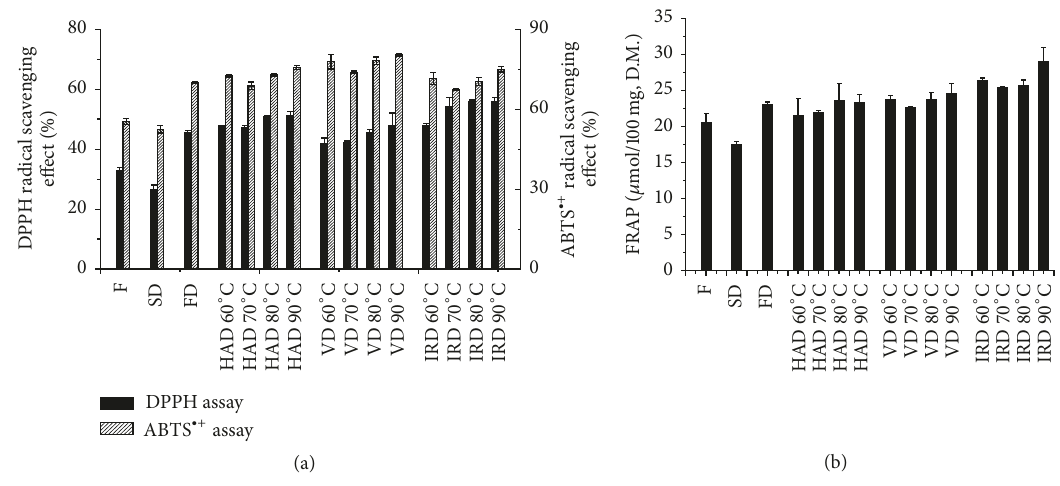
Figure 5: Effect of different methods on the antioxidant activity of tangerine peels: ABTS, DPPH (a), and FRAP (b).